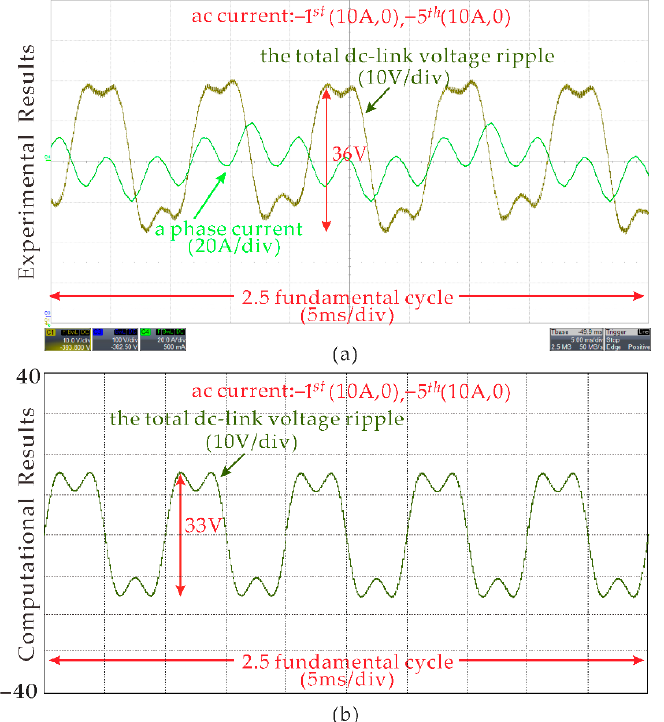
Figure 10. Experimental and computational results of the dc-link voltage ripple when the ac currents contain − 1st (10A, 0) and − 5th (10A, 0): ( a ) experimental results; ( b ) computational results.